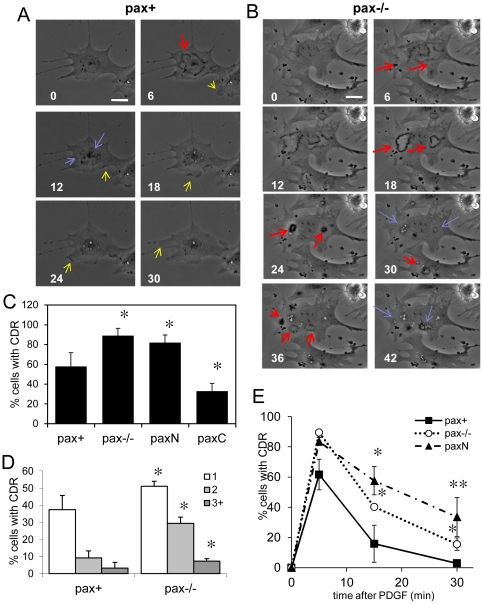
Pax−/− and paxN cells form more CDRs than pax+ and paxC cells and undergo repeated rounds of CDR formation in response of PDGF.Live cells were imaged before and after addition of PDGF (25 ng/ml) by phase-contrast time-lapse microscopy. A) Pax+ cell shows formation of a CDR (red arrow) and lateral membrane extension (yellow arrow). By 12 min, the CDR has been completely internalized into macropinosomal structures (blue arrows). Lateral ruffling continues and no further CDRs form through 30 min (and beyond). B) Pax−/− cells form several CDRs per cell which persist through 18–24 min before being completely internalized (red arrows) into multiple macripinosomes that remain in the cytosol (blue arrows). Multiple rounds of CDR formation take place in the same cells at 30 and 36 min. (Similar dynamics were observed in paxN cells by time-lapse.) Scale bar = 10 µm. C) Percent of CDR-positive pax+, pax−/−, paxN, and paxC cells grown on unpatterned FN stimulated with PDGF for 5 min, fixed, and stained for F-actin. n>200 cells per genotype. * p<0.01 compared to pax+. D) Percent of unpatterned cells with 1, 2, and 3 or more CDR at 5 min. * p<0.01 compared to pax+. E) Quantification of percent of cells with CDR from time-lapse movies of cells pax+, pax−/−, and paxN cells stimulated with PDGF. n>40 cells per genotype. * p<0.01. ** p<0.001.